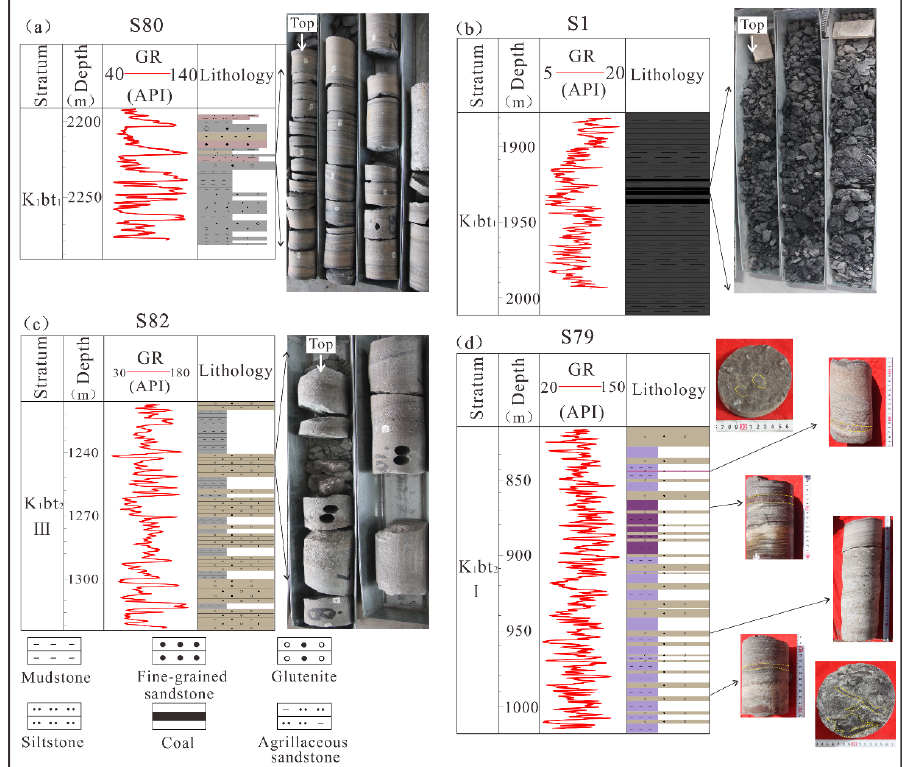
Figure 11. Lithological characteristics of the study area in different sedimentary periods. ( a ) well S80, gray pebbled fine sandstone and brown-red argillaceous siltstone, ( b ) well S1, thick layer of black carbonaceous mudstone and a coal seam, conchostracan fossils with fewer plant debris fos- sils ( c ) well S82, varicolored glutenite and gray-white mudstone, ( d ) well S79, purple to purple-red mudstone and varicolored glutenite, plant debris fossils.